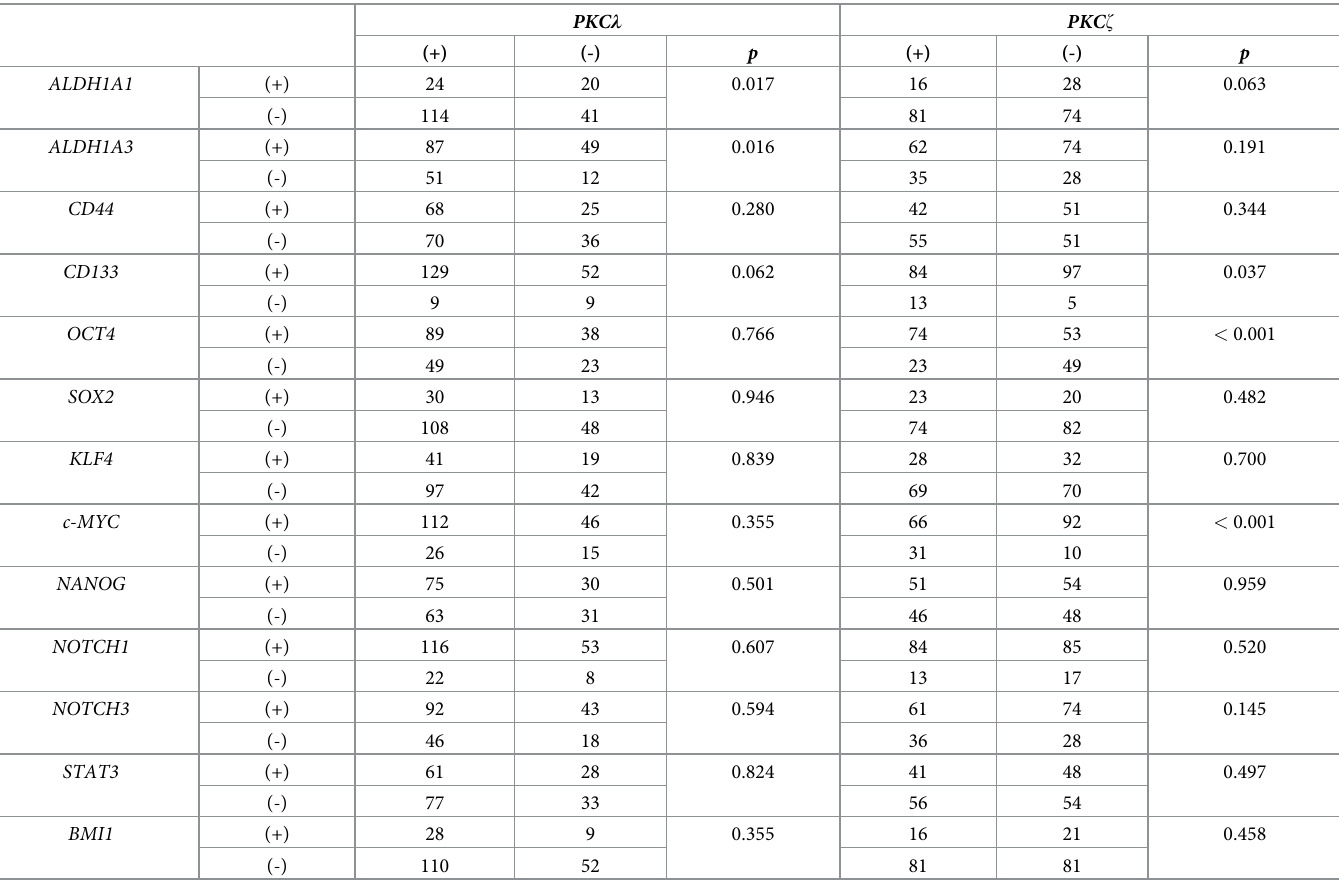
Table 1. Expression of PKC λ an d PKC z and several stemness marker genes in basal-like breast